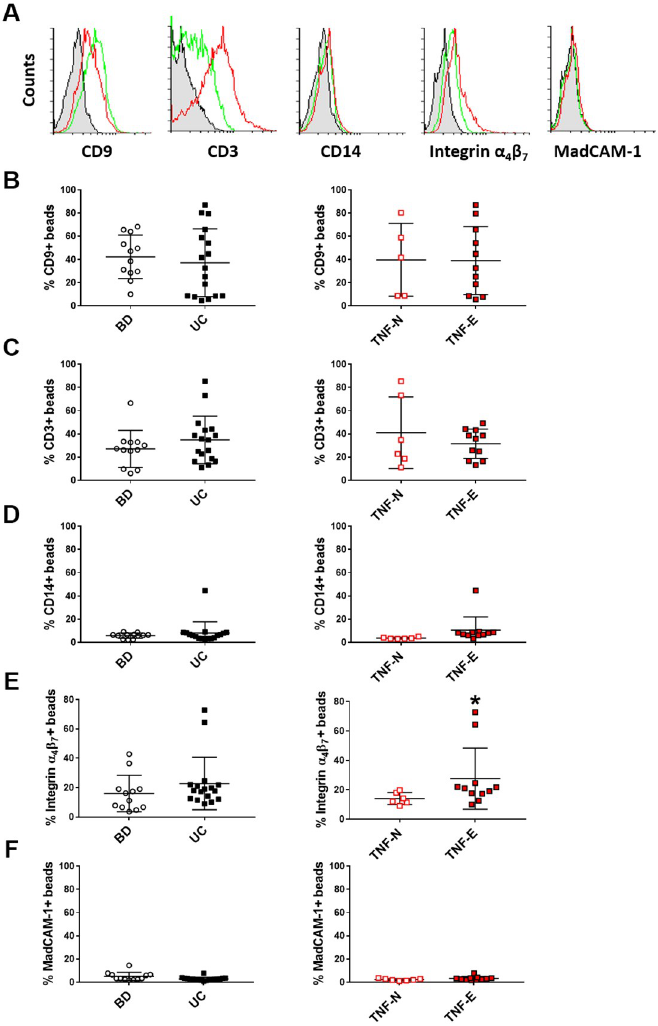
Fig 2. Circulating exosomes express α 4 β 7 integrin. (A) Purified vesicles isolated from serum of blood donor (CTRL) and UC patients subdivided in anti- TNF α na ï ve (TNF-N) and anti-TNF α antagonist exposed (TNF-E) were captured on antibody-coated beads and analyzed by flow cytometry. Representative plots of the FACS analyses for CTRL(green line) and UC-derived exosomes (red line) are shown. Graphs reported the expression levels (percentage of exosome- bound beads compared with beads alone) of CD9 (B), CD3 (C), CD14 (D), α 4 β 7 integrin (E) and MadCAM-1 (F) on exosome surface, � p < 0.05 compared to anti- TNF α na ï ve